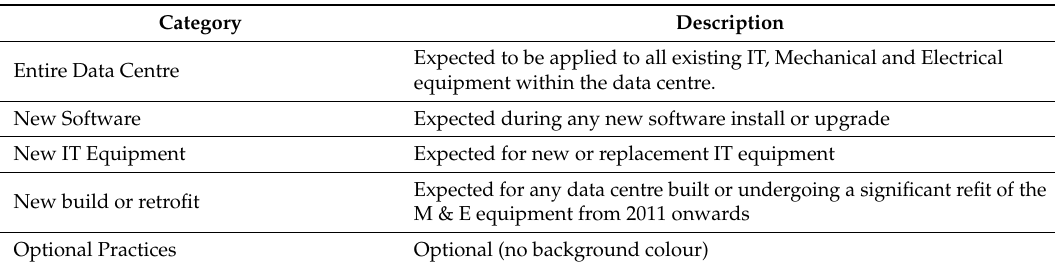
Table 4. Minimum expected and optional Best practices